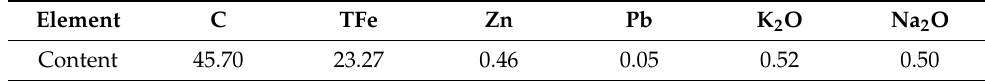
Table 1. Blast furnace dust composition (wt%).